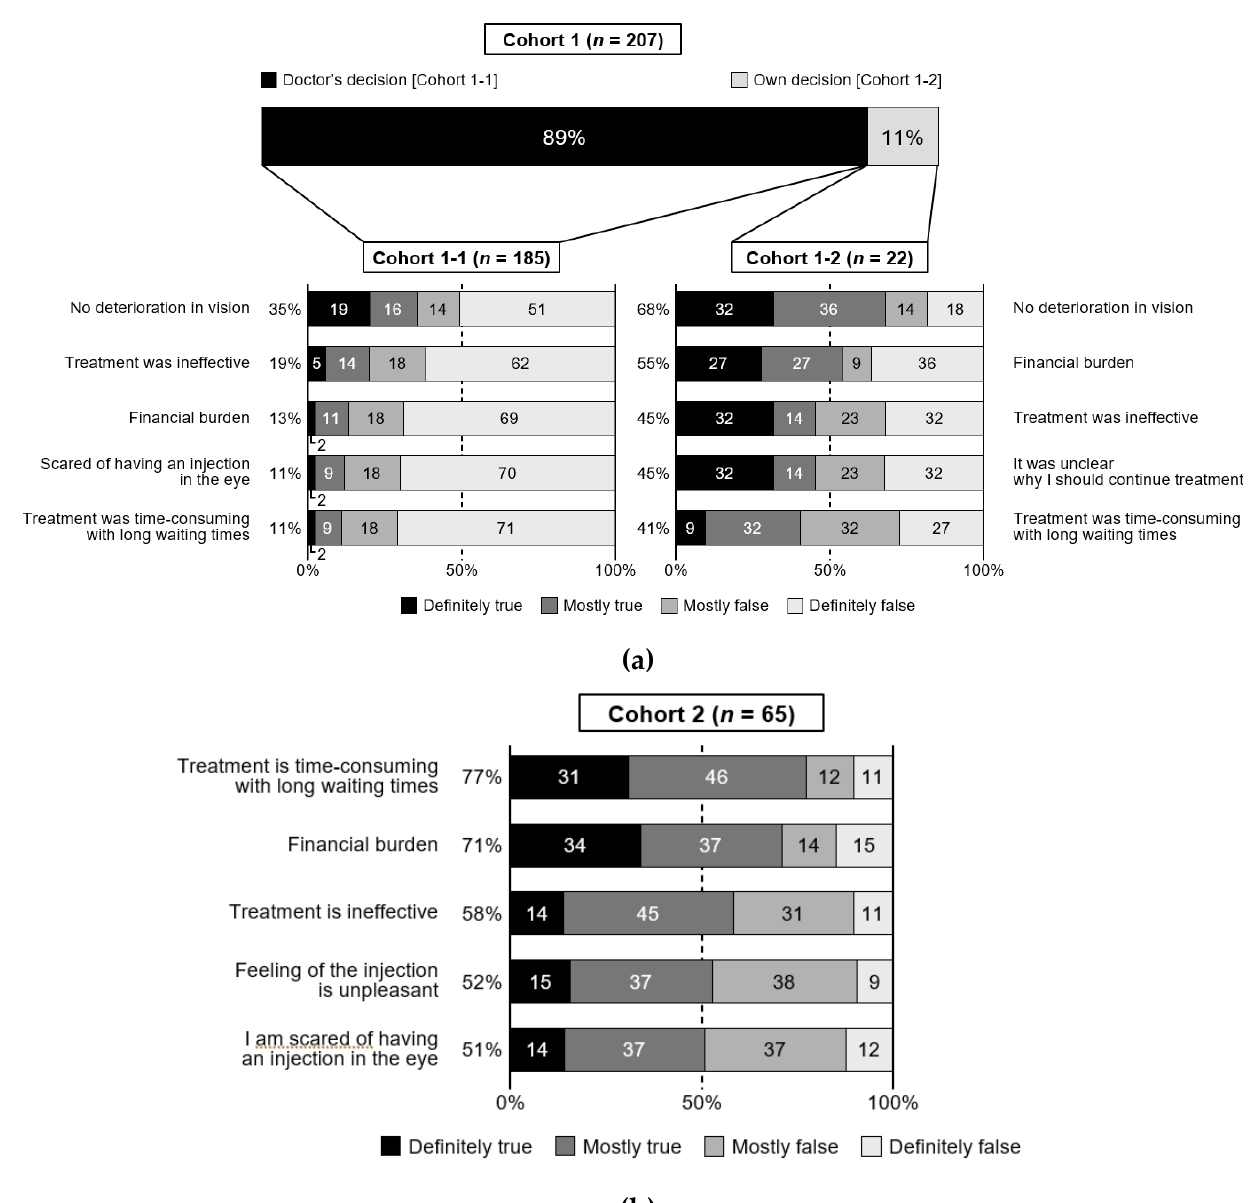
Figure 3. Top five reasons for treatment discontinuation in Cohort 1 ( a ) and dissatisfaction with treatment in Cohort 2 ( b ). Reasons are ordered in descending order according to the percentage of patients reporting “definitely true” or “mostly true”. The other reasons for discontinuation in Cohort 1 or dissatisfaction in Cohort 2 are listed in Tables S4 and S5, respectively. Cohort 1-1 patients discontinued at their doctor’s decision; Cohort 1-2 patients discontinued at their own decision; Cohort 2 patients were continuing